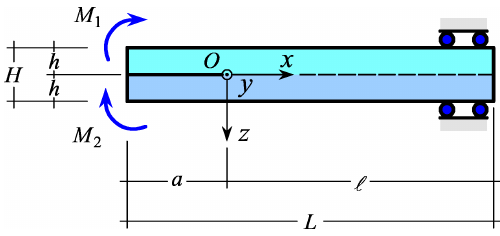
Figure 7. Double cantilever beam specimen with uneven bending